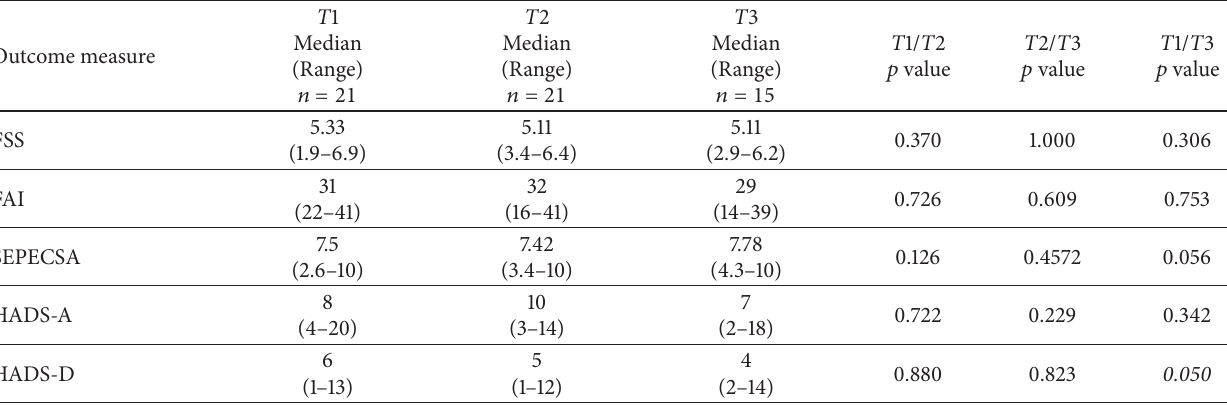
Table 2: Median scores FSS, FAI, HADS, and SEPECSA at T 1, T 2, and T 3.